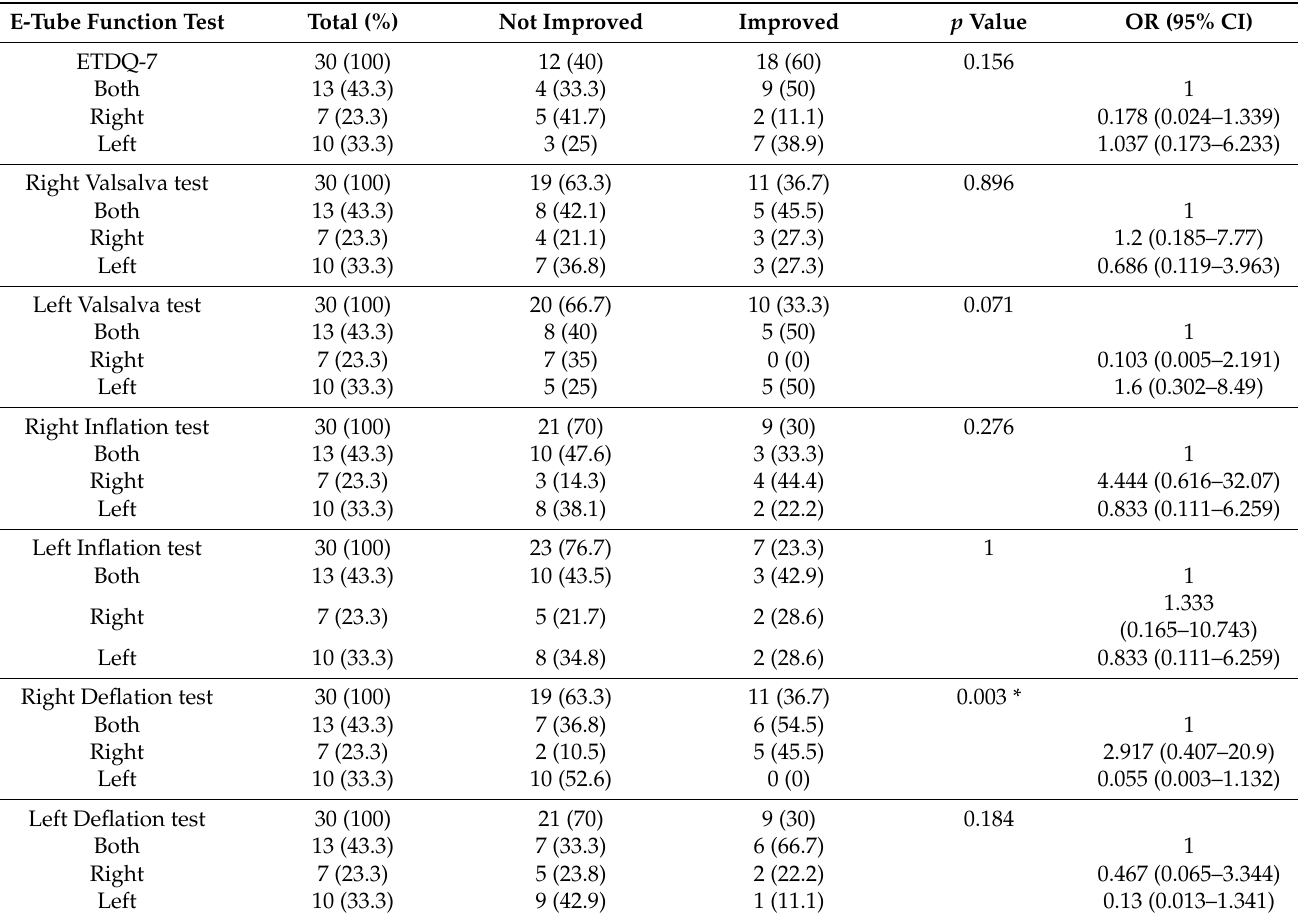
Table 4. Association analysis between the sinusitis side and the E-tube function test